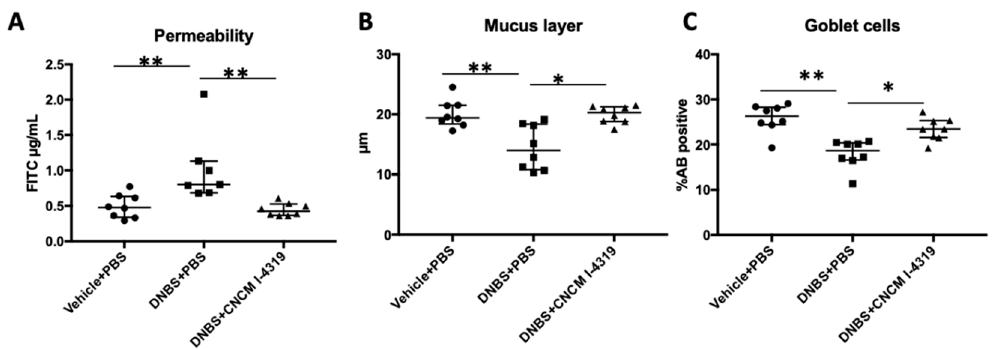
Figure 5. In vivo permeability measurements and effect on Goblet cells and mucus production in LGI model. For in vivo measurements of gut permeability, animals were orally gavaged with FITC-dextran ( A ). Percentage of positive cells stained with AB (Alcian Blue) and mucus layer thickness measured by muc-2 immunohistochemistry ( B , C ). Control non-inflamed (vehicle-PBS), control inflamed (DNBS-PBS), B. bifidum CNCM I-4319 strain (DNBS-CNCM-I4319). *: p < 0.05 **: p < 0.01.